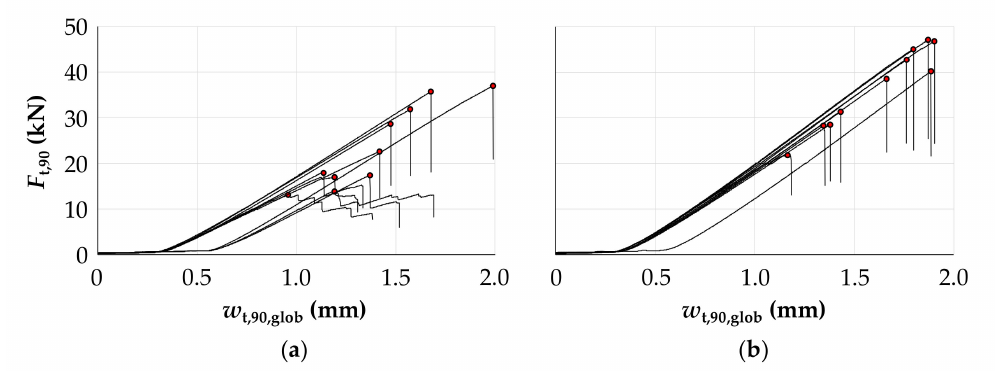
Figure 11. Force-displacement diagrams for half of ( a ) series 5sGL and ( b ) series 5sCL; global displacement which includes the total deformation of test setup and test